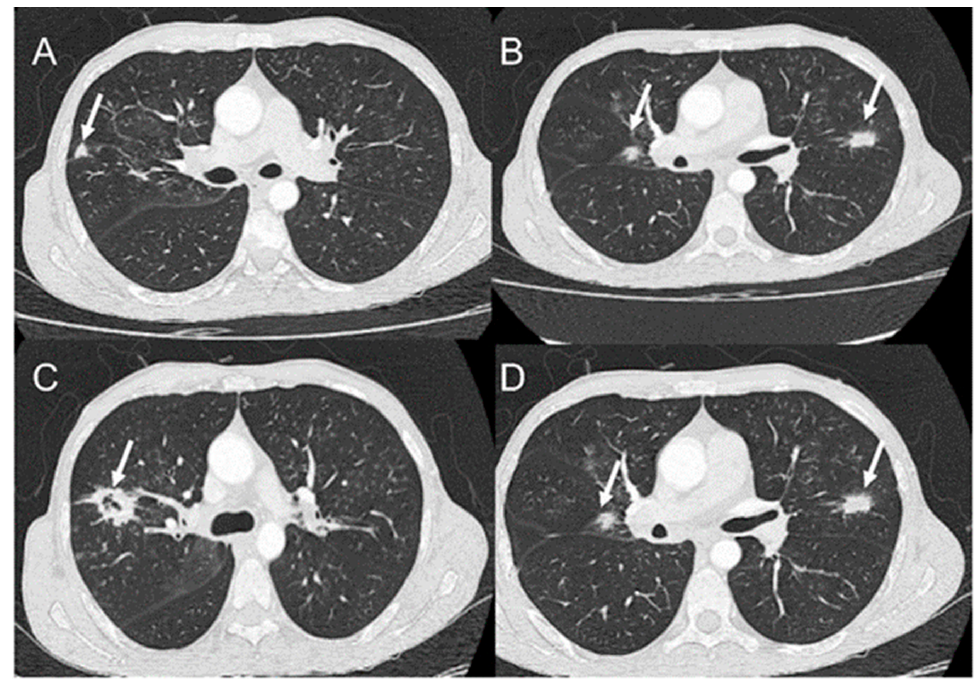
Figure 5. Computed tomography showing nodular opacities bilaterally distributed (arrows in A – D ), with cavitation (arrow in C ), as shown from top to bottom in figures ( A – D ).